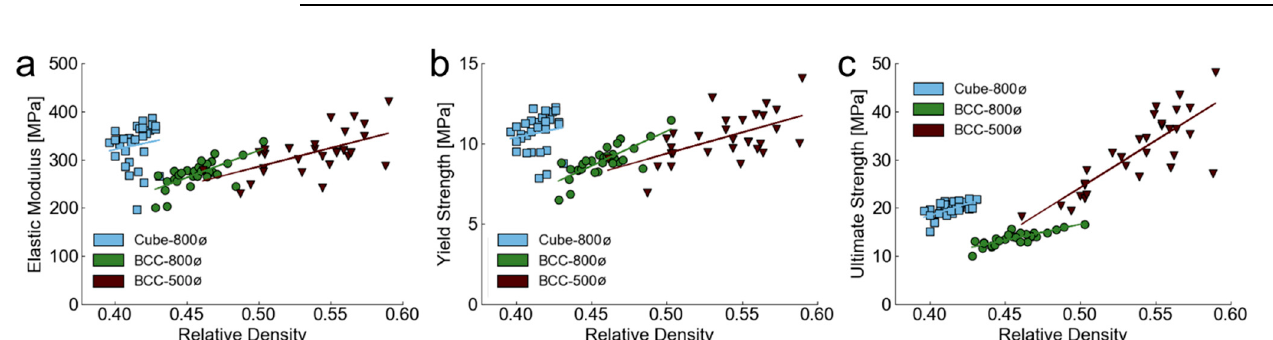
Figure 12. Mechanical property measurements for each tested sample according to relative density for ( a ) elastic modulus E m , ( b ) yield strength Y s , and ( c ) ultimate strength U s .